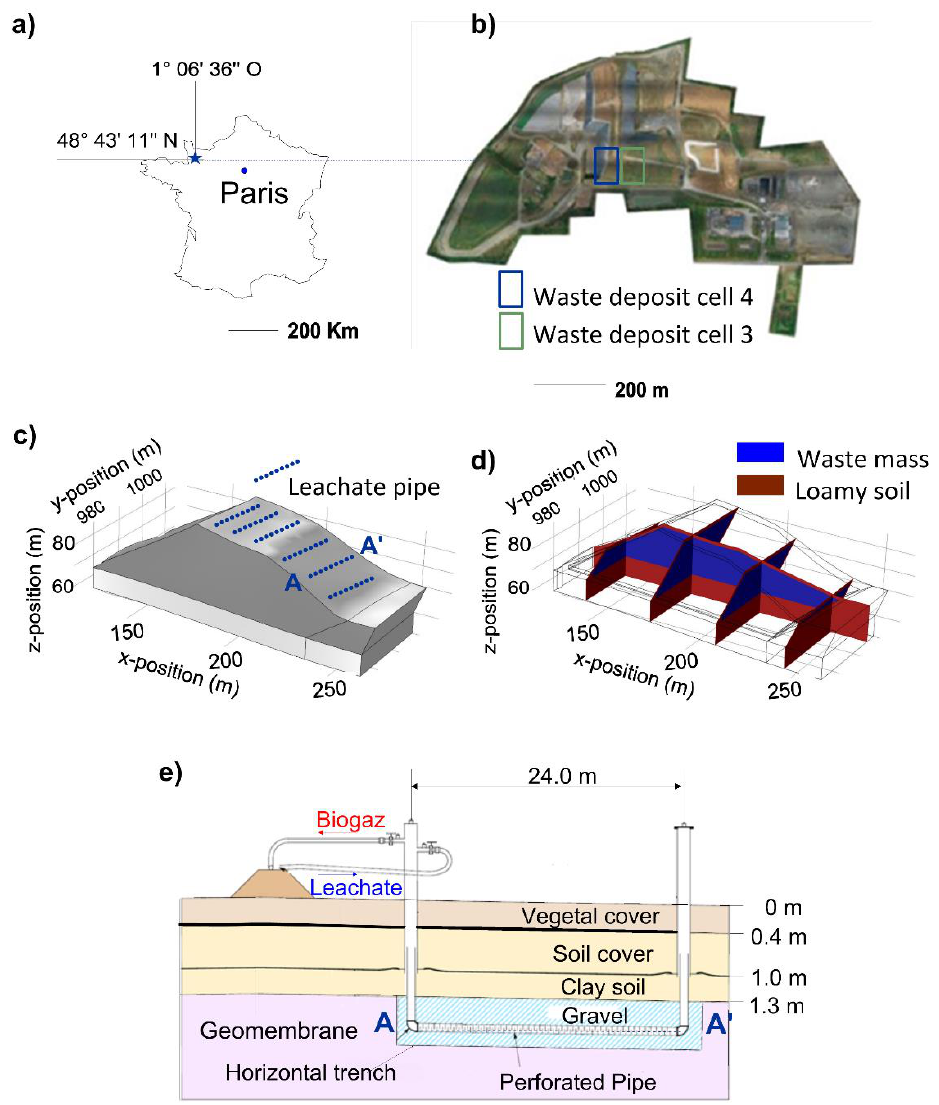
Figure 1. ( a ) Location of the experimental site, ( b ) aerial photograph of the industrial site, ( c ) geometry of experimental waste deposit cell CELL4, ( d ) internal geometry of the waste deposit CELL4 and ( e ) mixed biogas collection and leachate recirculation pipe in a horizontal